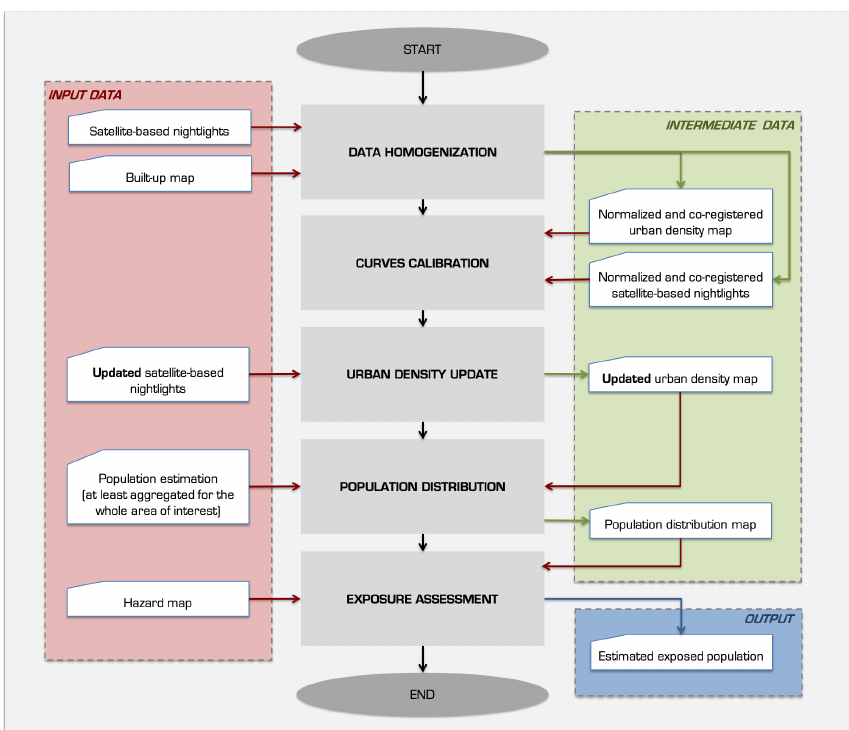
Figure 2. Graphical representation of the proposed algorithm for the estimation of population exposed to natural hazards, which reports the main procedural steps, input data, intermediate products and the final